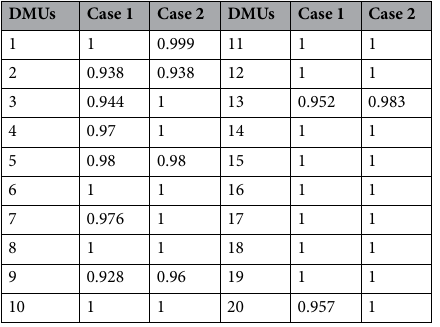
Table 4. Efficiency of warehouses in the first and second